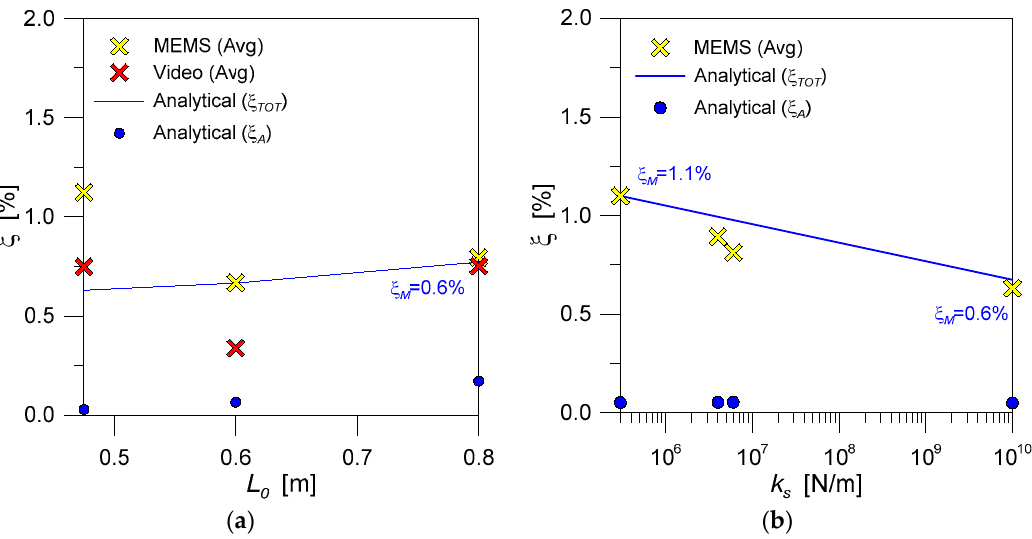
Figure 13. Analytical estimation of the damping ratio ξ for ( a ) cantilever and ( b ) beam-like monolithic glass samples.